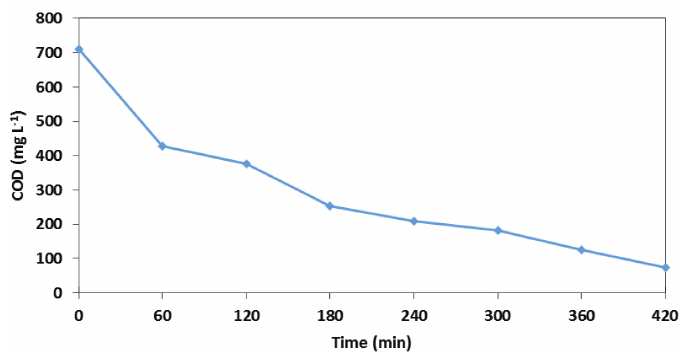
Fig. 5 – Effect of reaction time on COD removal of petro- chemical wastewater using PPc (Voltage: 1.5 V, pH = 4, elec - trode distance: 2